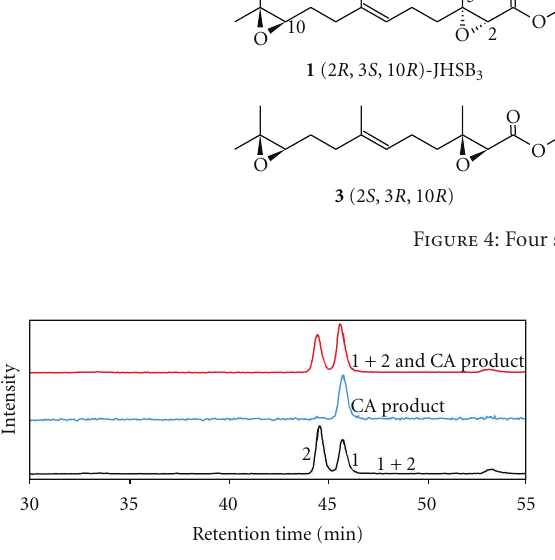
Figure 5: Chiral GC-MS(CI) analysis of synthetic standards of JHSB 3 ( 1 ) and isomer 2 and natural product by the CA of Plautia stali using an Rt- β DEXcst column. Vertical axis indicates signal intensity for m/z 300, [M+NH 4 ] + . Black, blue, and red lines indicate analysis of JHSB 3 ( 1 ) and isomer 2 (10ng each), CA product, and cochromatography of these two samples, respectively